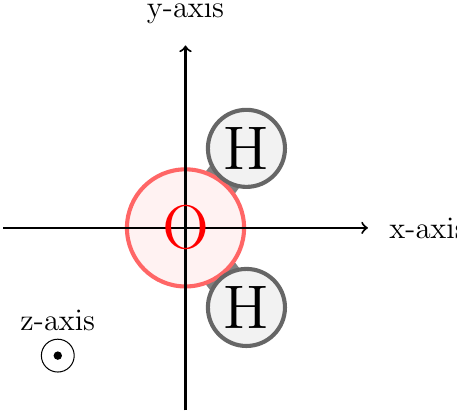
Figure 1: Axis alignment of the QM water solute as applied during polarizability and charge fitting. The oxygen is placed at the origin of the axis system and the hydrogens are placed in the positive x -axis regime. Only the sign of the y -axis value differentiates between the first and second hydrogen. The molecule is placed in the x – y plane and the z -axis is defined as x ×